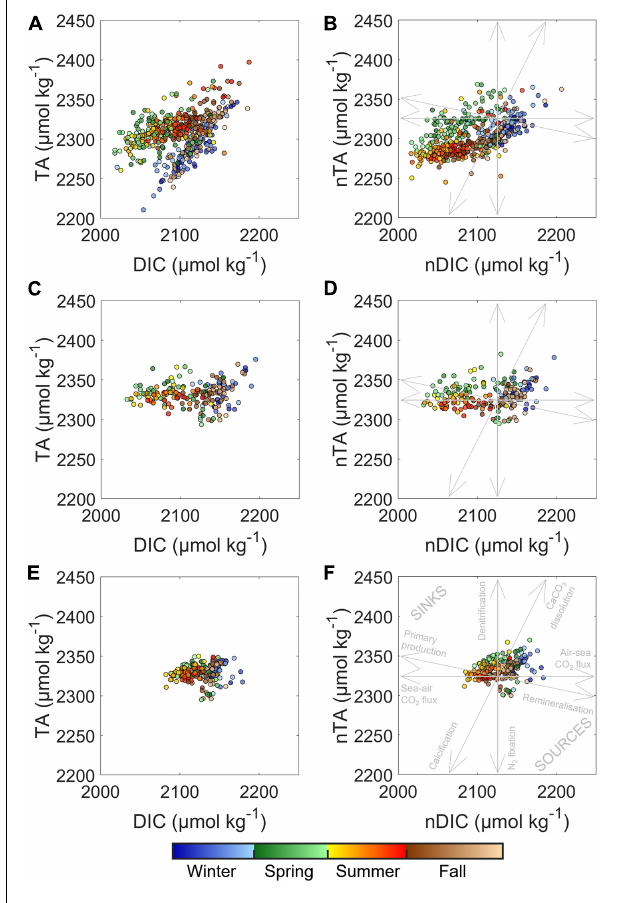
FIGURE 7 | DIC ( µ mol kg − 1 ) vs. TA ( µ mol kg − 1 ) and nDIC ( µ mol kg − 1 ) vs. nTA ( µ mol kg − 1 ) at (A,B) SOMLIT-Brest, (C,D) SOMLIT-pier, and (E,F) SOMLIT-offshore with the (F) dominant annual processes affecting the carbonate system and their stoichiometric influence on nDIC and nTA.